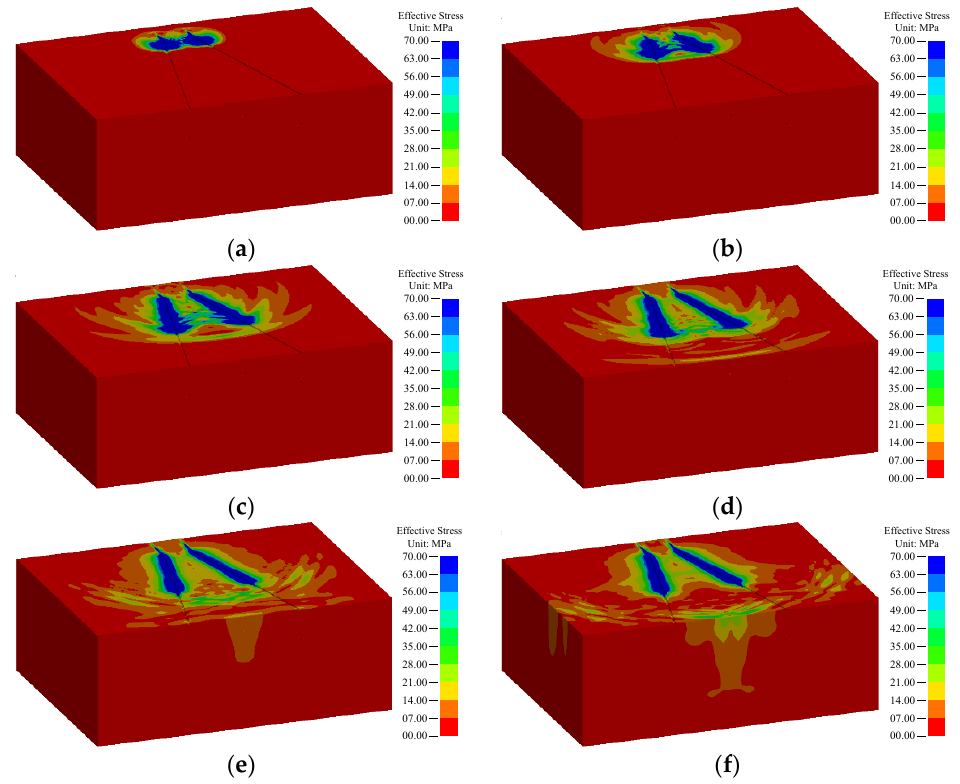
Figure 6. Dynamic evolution process of stress wave after charge detonation in cutting holes: ( a ) 080 µs, ( b ) 160 µs, ( c ) 320 µs, ( d ) 470 µs, ( e ) 600 µs, and ( f ) 800 µs.